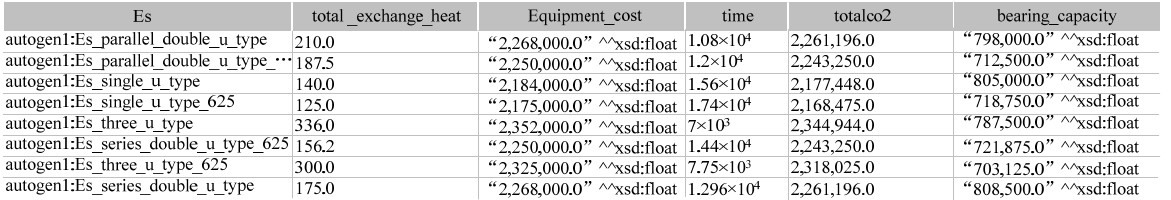
Figure 11. Execution and results of querying R.1 in Table 4.